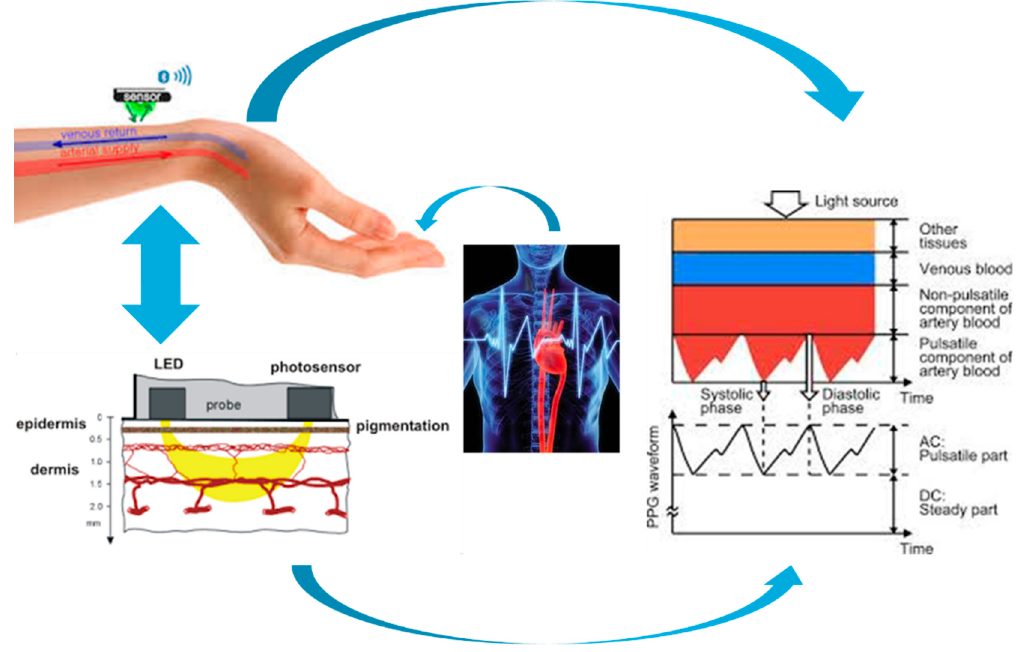
Figure 2. The physiological phenomena underlying photoplethysmgraphic (PPG) pattern formation.